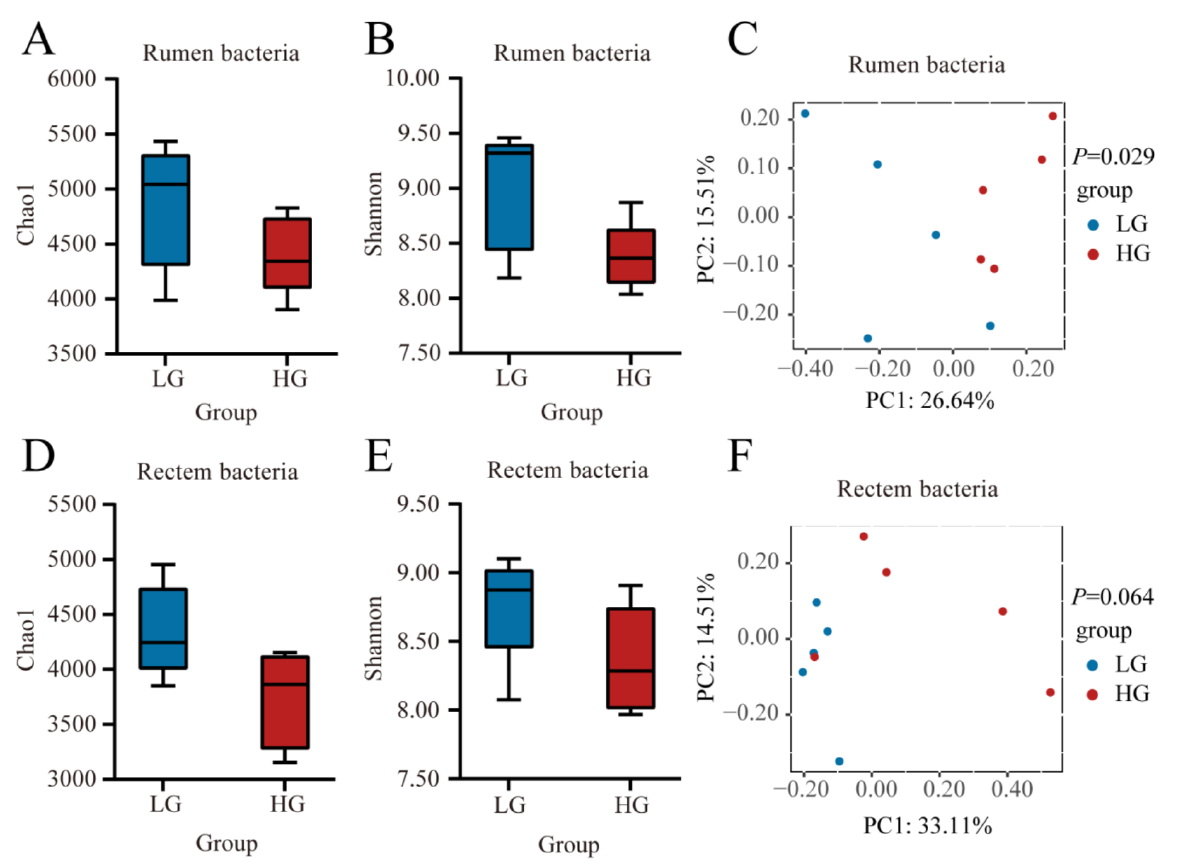
Figure 3. Bacterial communities and differences between the five lambs with the lower average daily gain (LG) and the five lambs with the higher average daily gain (HG) in the gastrointestinal tract at 90 days of age. ( A ) Chao 1 index and ( B ) Shannon index in the rumen. ( C ) Principal coordinate analysis (PCoA) of bacterial Bray-Curtis distance in LG and HG groups in the rumen. ( D ) Chao 1 index and ( E ) Shannon index in the rectum. ( F ) PCoA of bacterial Bray-Curtis distance in LG and HG groups in the rectum. The whiskers represent the minimum and maximum